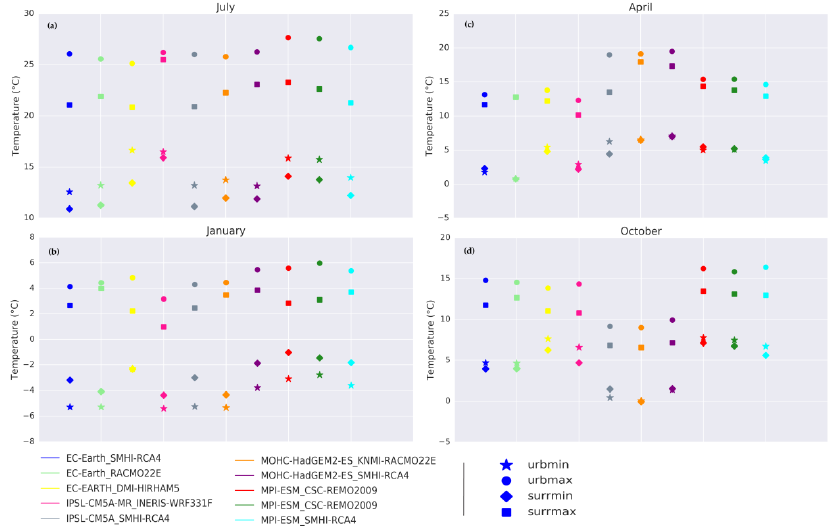
Figure 5. Temperature minimum and maximum for Berlin (urbmin / urbmax) and its surroundings (surrmin / surrmax) for the ten-model combination from the EURO-CORDEX multi-model ensemble. Daily average between 1971 – 2000 for the monthly mean of ( a ) July, ( b ) January, ( c ) April, and ( d ) October.